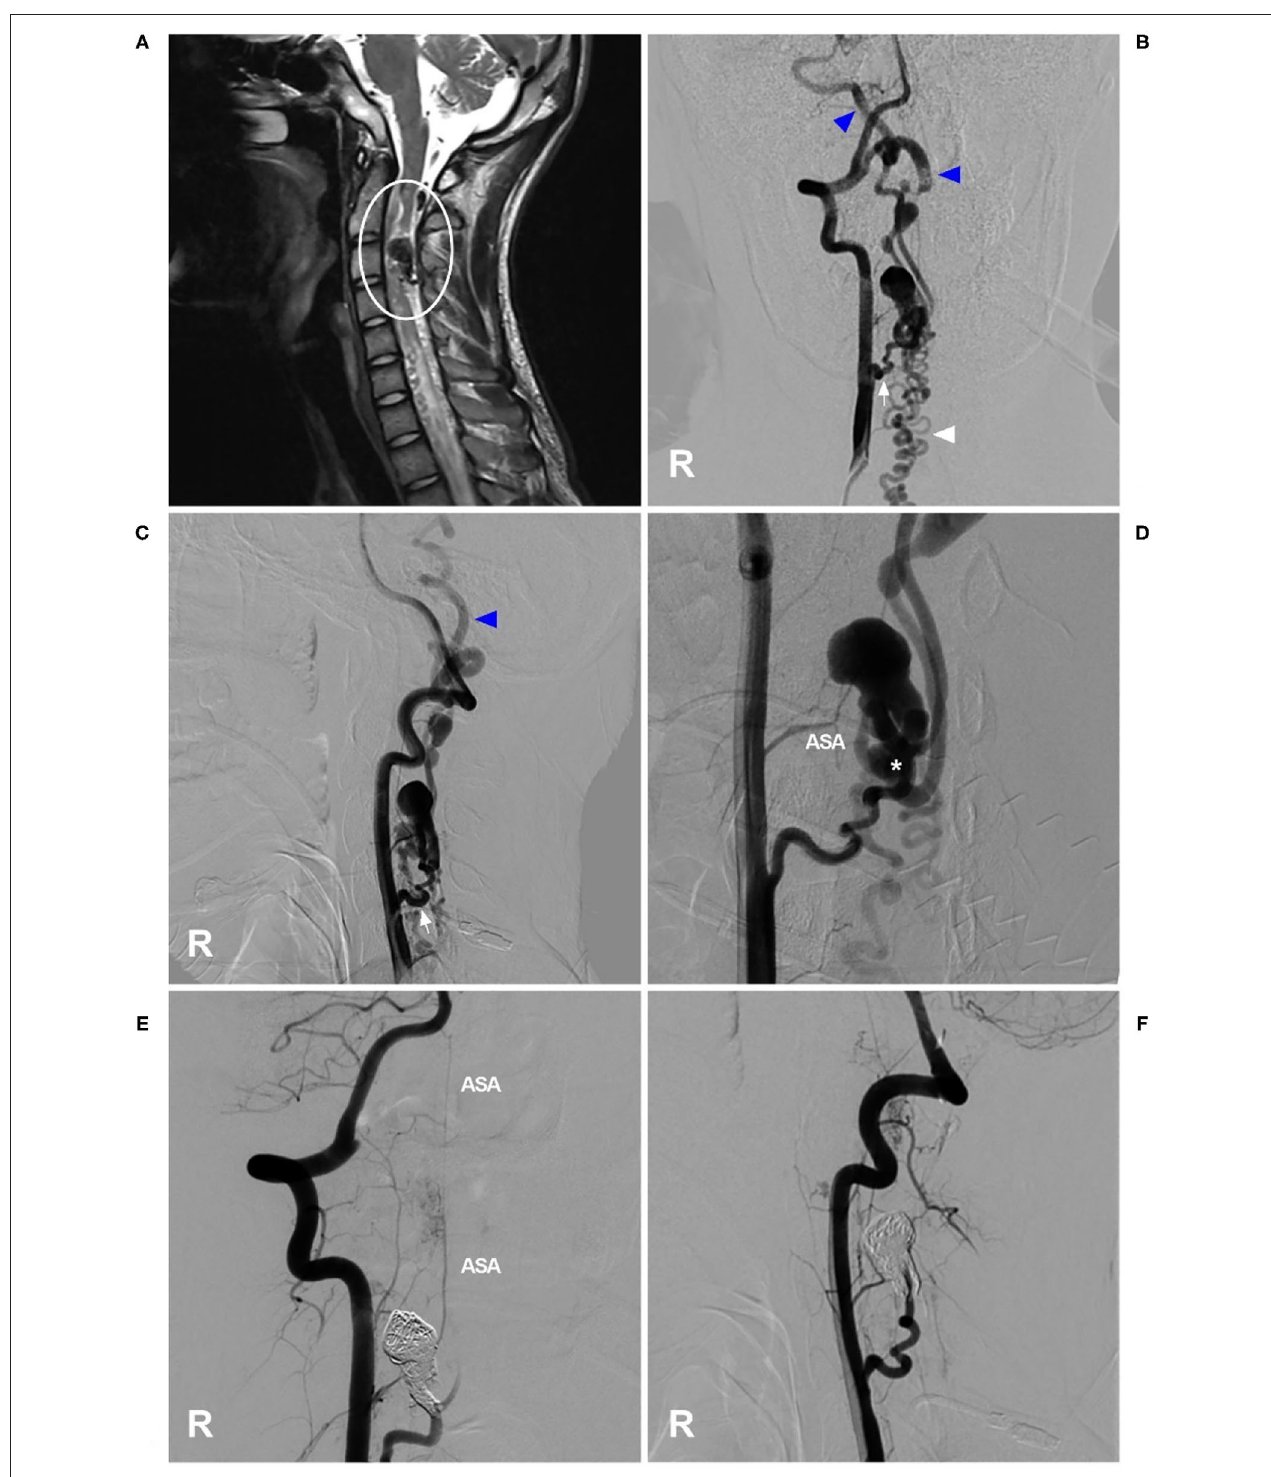
FIGURE 3 | EVT of a cervical perimedullary arteriovenous fistula. (A) MRI showed a PAVF near the C3 level (circle). (B,C) Right VA anteroposterior view (B) and lateral view (C) angiograms showed that the PAVF was mainly supplied by a dilated radiculomeningeal artery (arrow), with draining to the cranium (blue triangles) and lower neck (white triangle), and that the draining veins were dilated. (D) An angiogram showed the shunt point of the PAVF (asterisk). The ASA could be seen as a bystander. (E,F) Right VA anteroposterior view (E) and lateral view (F) postoperative angiograms showed that the PAVF was embolized by coiling. The ASA remained intact as a bystander. ASA, anterior spinal artery; EVT, endovascular treatment; MRI, magnetic resonance imaging; PAVF, perimedullary arteriovenous fistula; R, right; VA, vertebral artery.